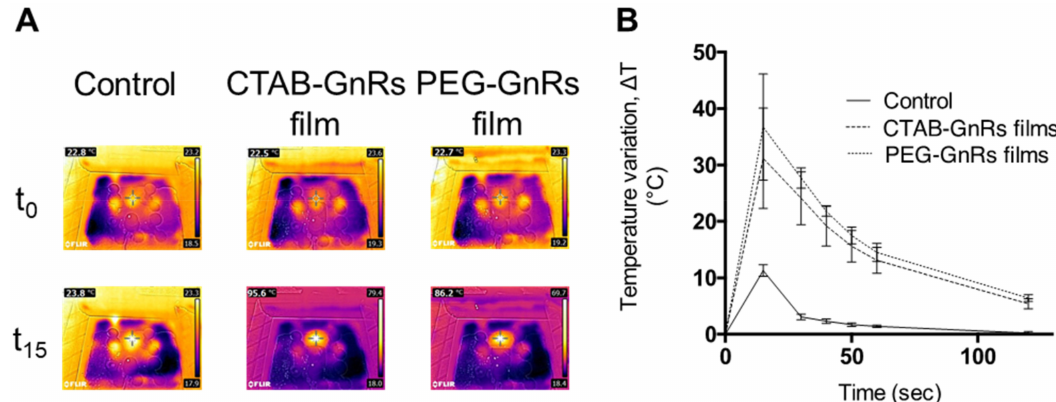
Figure 13. Heating capacity of polymeric films loaded with GnRs on neonate porcine skin. Representative thermal images of films on top of skin after 15 s of laser irradiation ( A ). Temperature increase of porcine skin measured with a thermocouple (mean ± SD, n = 3) ( B